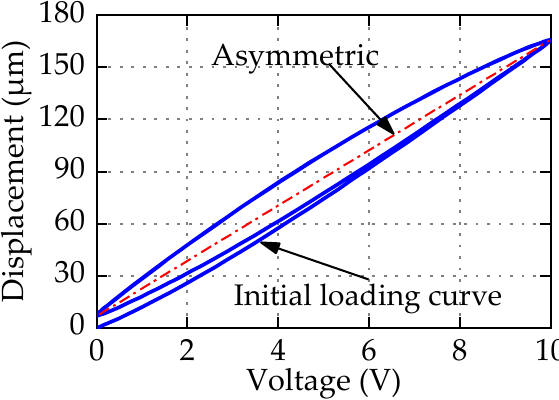
Figure 1. Asymmetric hysteresis loops of piezoelectric actuators (PEAs).